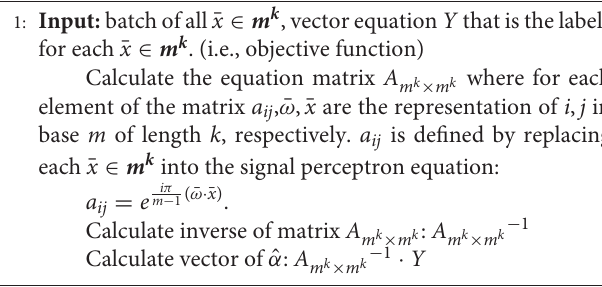
Algorithm 1 Learning algorithm for the signal perceptron based on a system of linear equations.